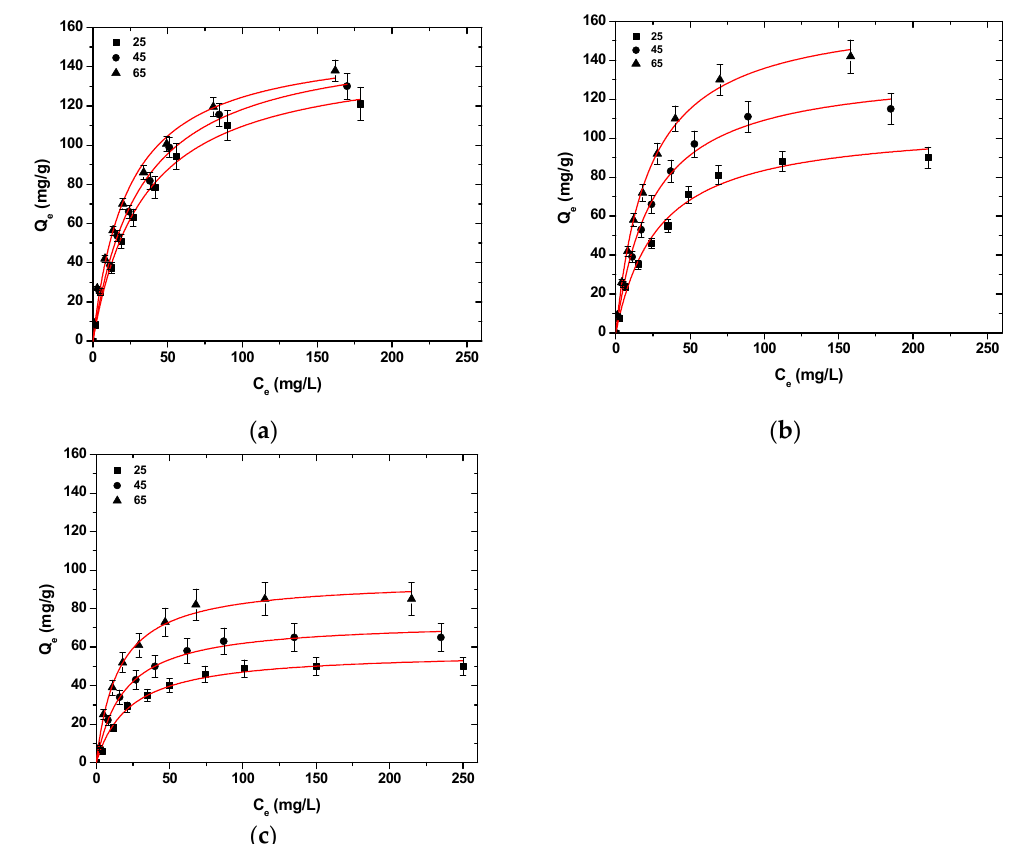
Figure 6. Isotherms for the uptake of ( a ) Ni 2+ ; ( b ) Hg 2+ ; ( c ) Ba 2+ from aqueous solutions (single component). Testing conditions: T = 25 – 65 °C, C 0 = 10.0 – 300.0 (mg/L), N = 160 rpm, V = 20.0 mL, t = 200 min, m = 0.02 g, pH = 6. Table 3. Equilibrium parameters for Ni 2+ , Hg 2+ , and Ba 2+ adsorption at 25, 45, and 65 ◦ C (single-component aqueous solutions) onto CS-HMF bioadsorbent.